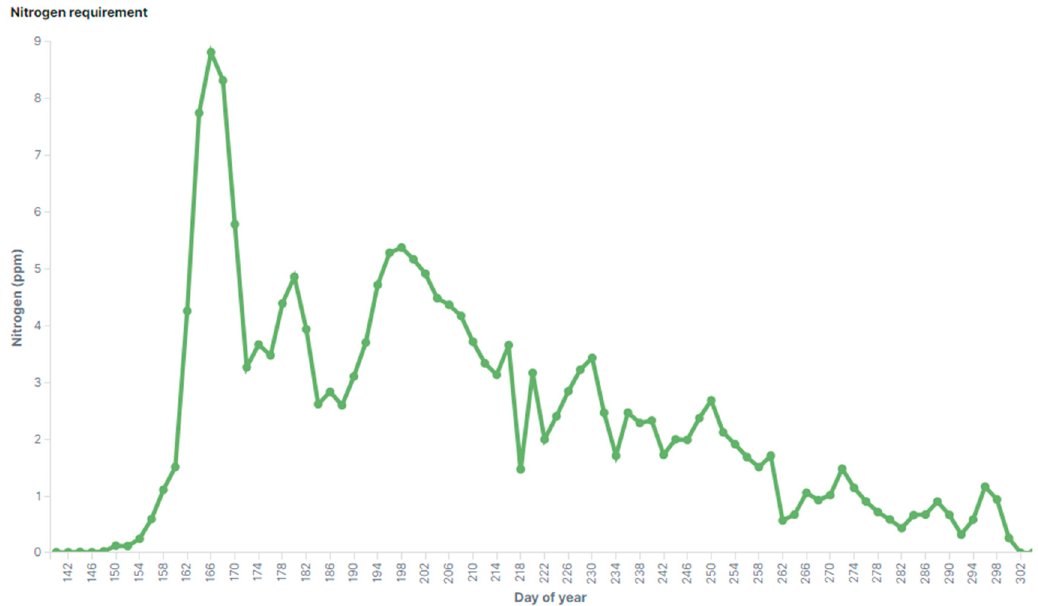
Figure 27. Conceptual Model—Plant’s daily nitrogen need.